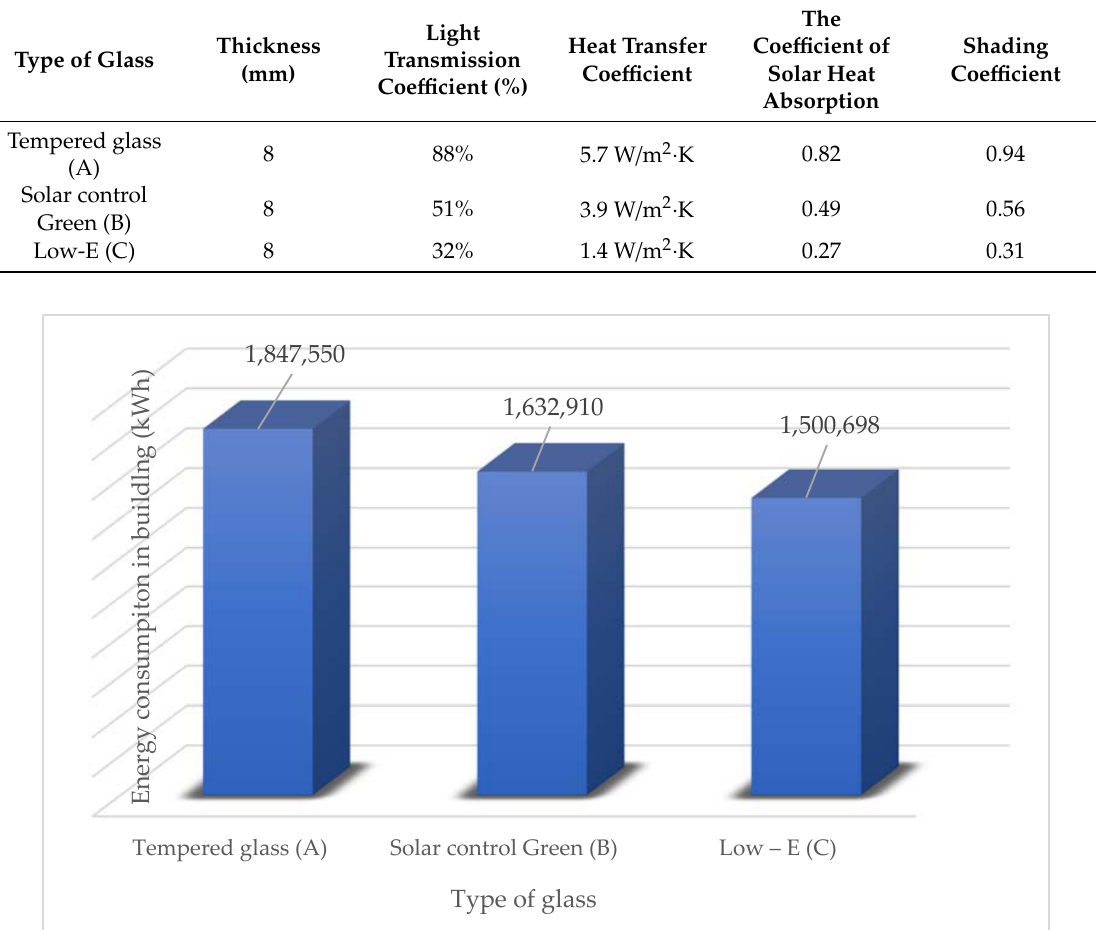
Figure 5. Total energy used in the simulation building in 1 year application ( Ei ).